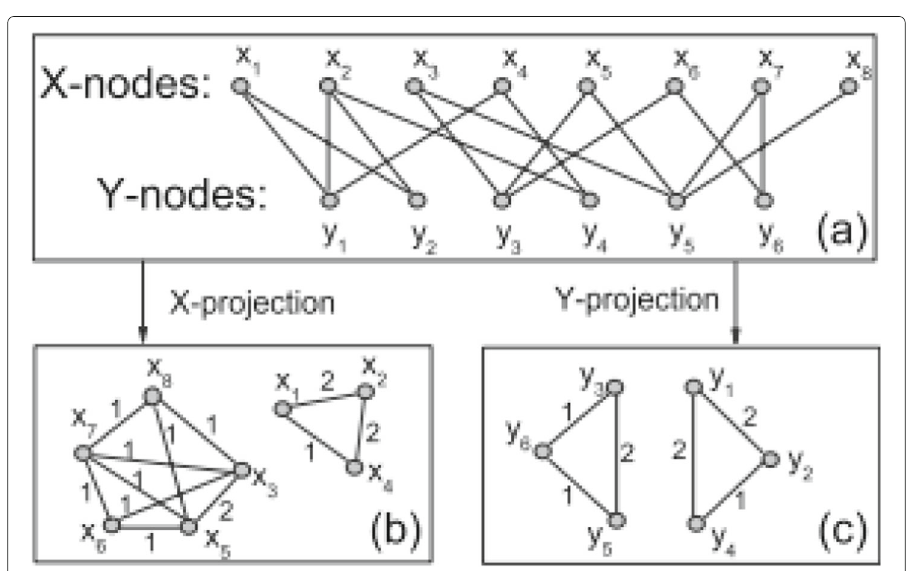
Fig. 15 Illustration of the one-mode projection form a bipartite